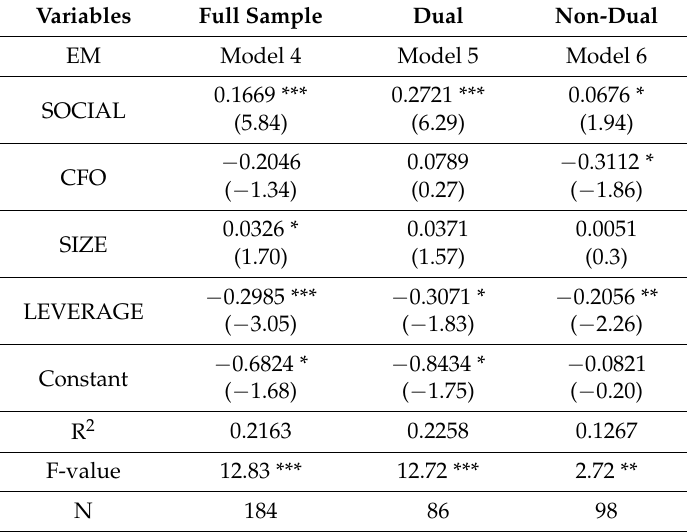
Table 5. Effects of social relationships on earnings management in presence of CEO